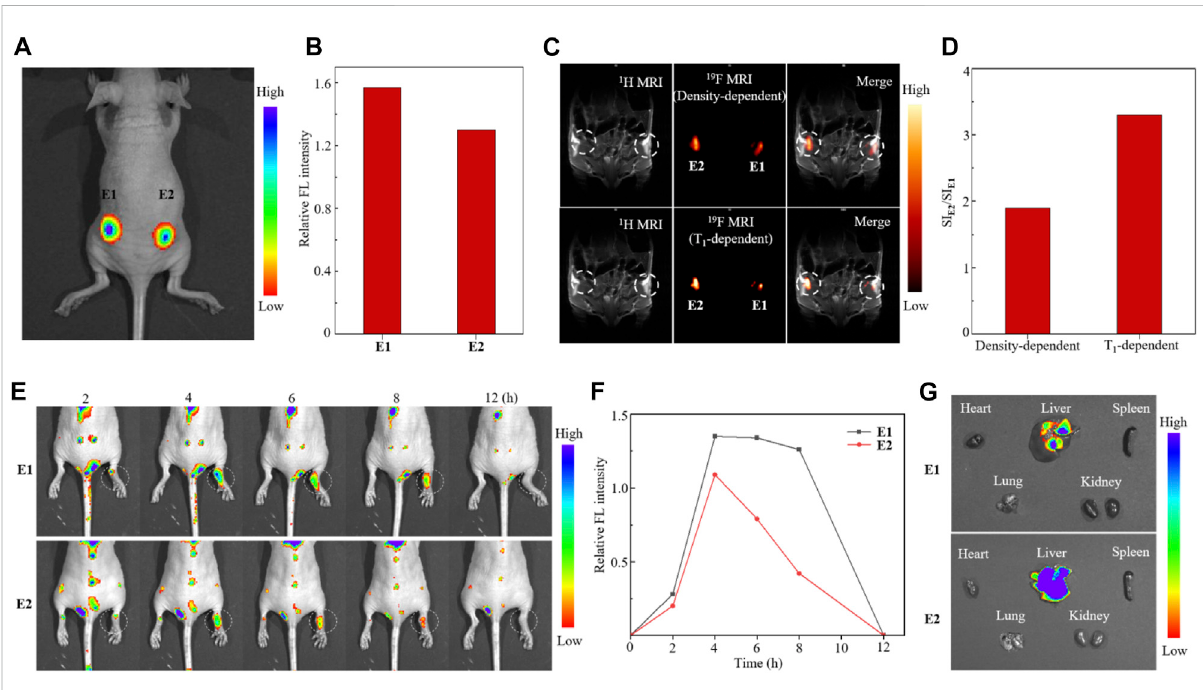
FIGURE 5 Fluorescence image (A) , quantitative analysis of relative FL intensity (B) , 19 F MRI [ (C) , upper: 19 F density-dependent images, lower: 19 F T 1 - dependent images], and quantitative analysis 19 F SI (D) of nude mice injected with nanoemulsion E1- and E2-labeled A549 cells. Time-dependent FL images (E) , quantitative analysis of FL intensity in the right paw region (F) , and FL images of internal organs [ (G) , collected 4 h post-injection] of mice with carrageenan-induced paw in fl ammation after tail vein injection of nanoemulsions E1 and